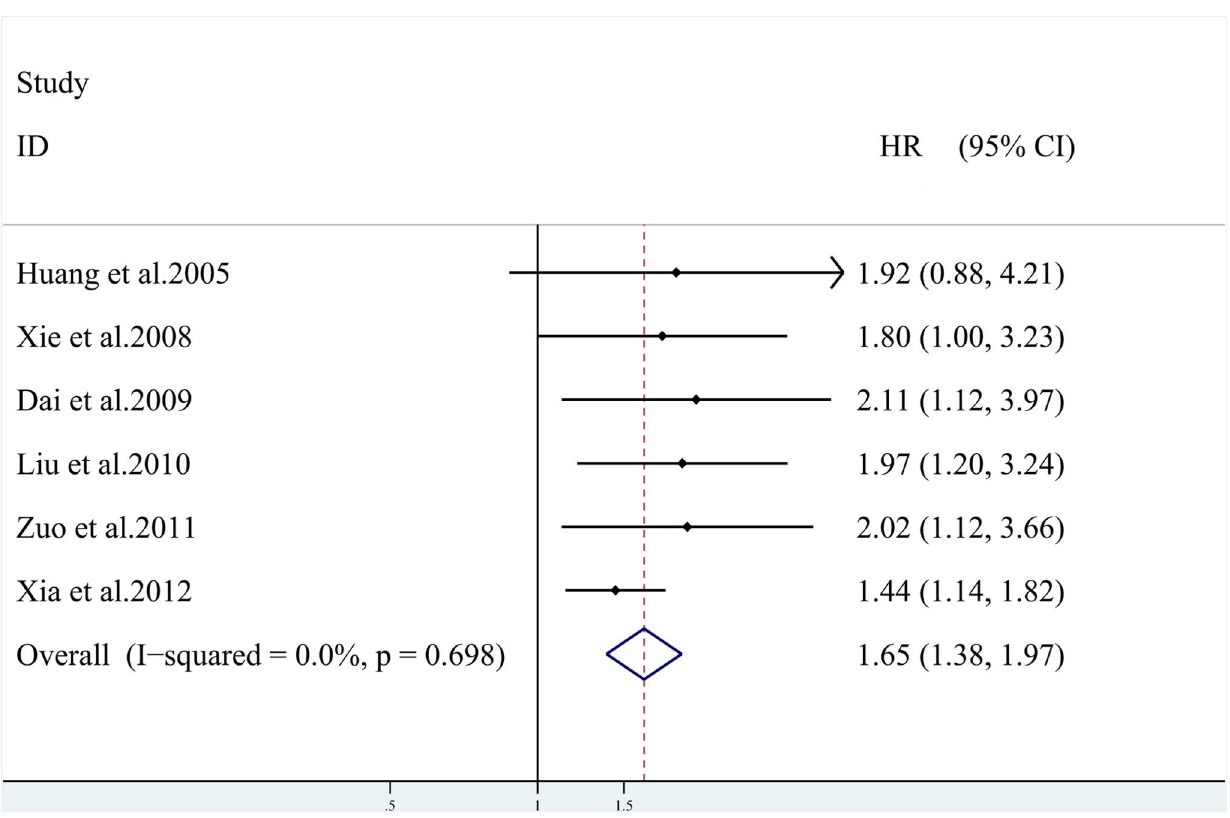
Figure 3. Plot illustrates findings from meta-analysis of the association between HIF-1 a overexpression and overall survival (OS) in 7 trials. Each study was shown by the name of the first author and the HR with 95% CIs. The summary HR and 95% CIs were also shown (according to the fixed effect estimations).